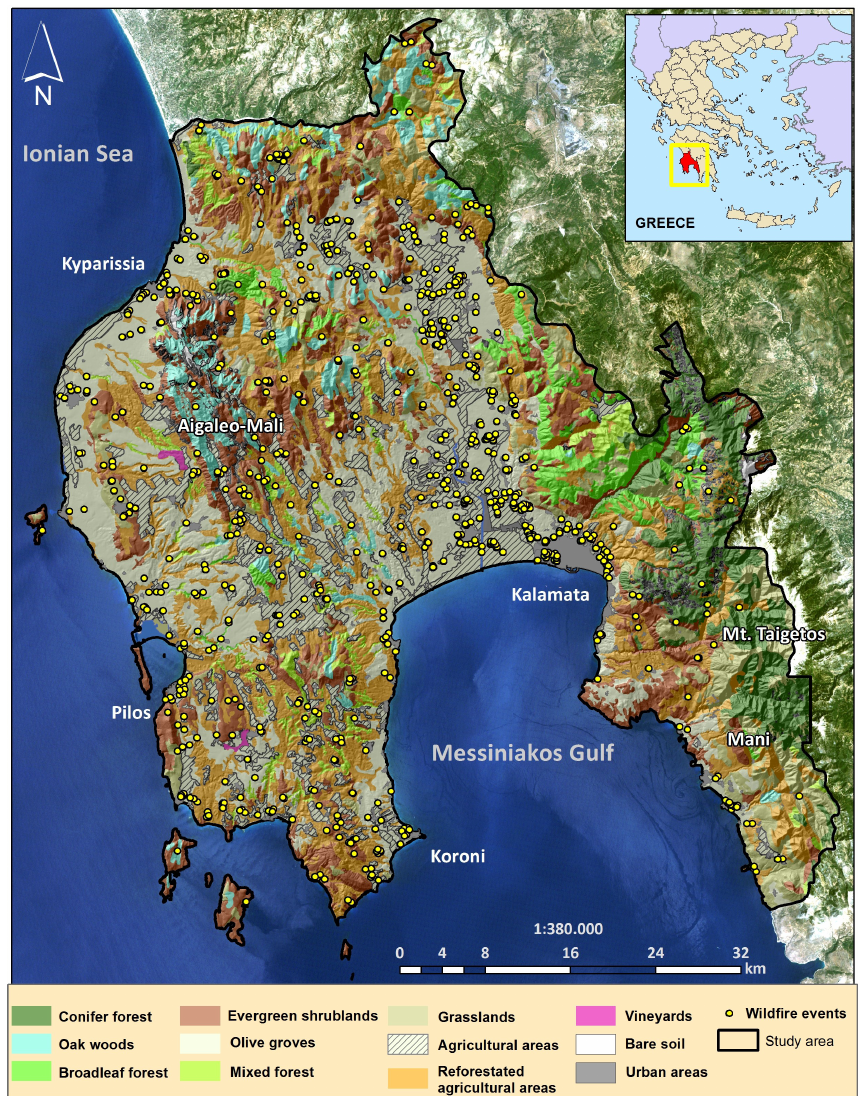
Figure 1. Land use/land cover types and fire ignitions from 2000 to 2013 in Messinia,